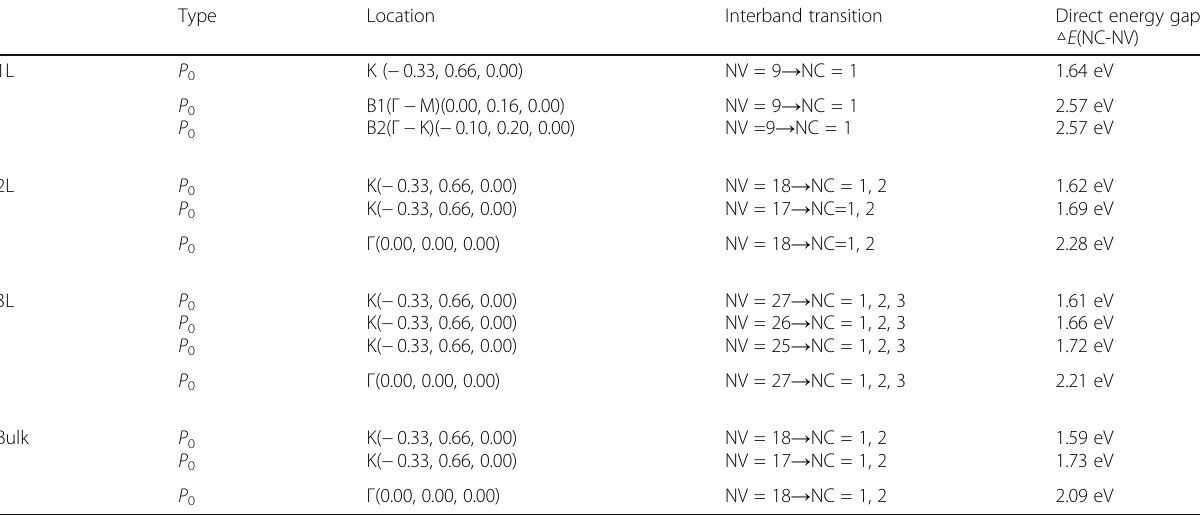
Table 2 Main critical points in interband transitions below 3 eV. For the meaning of the parameters in the table, please refer to Fig. 3 and Fig.